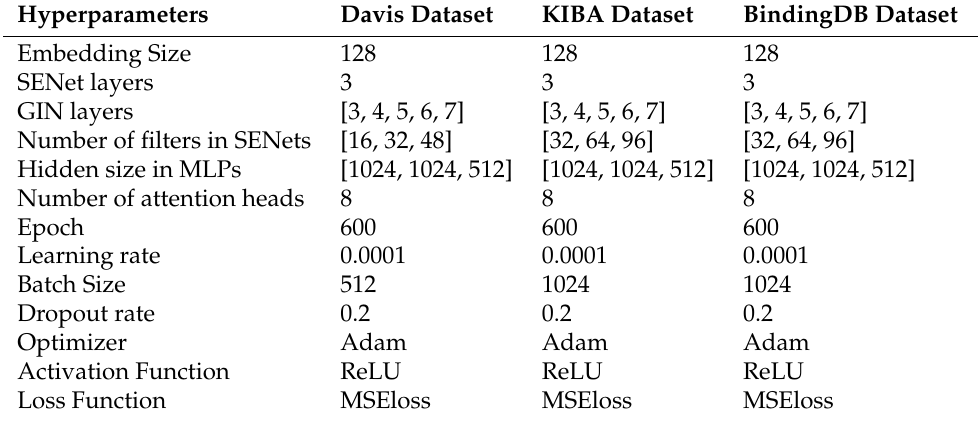
Table 2. The hyperparameters of